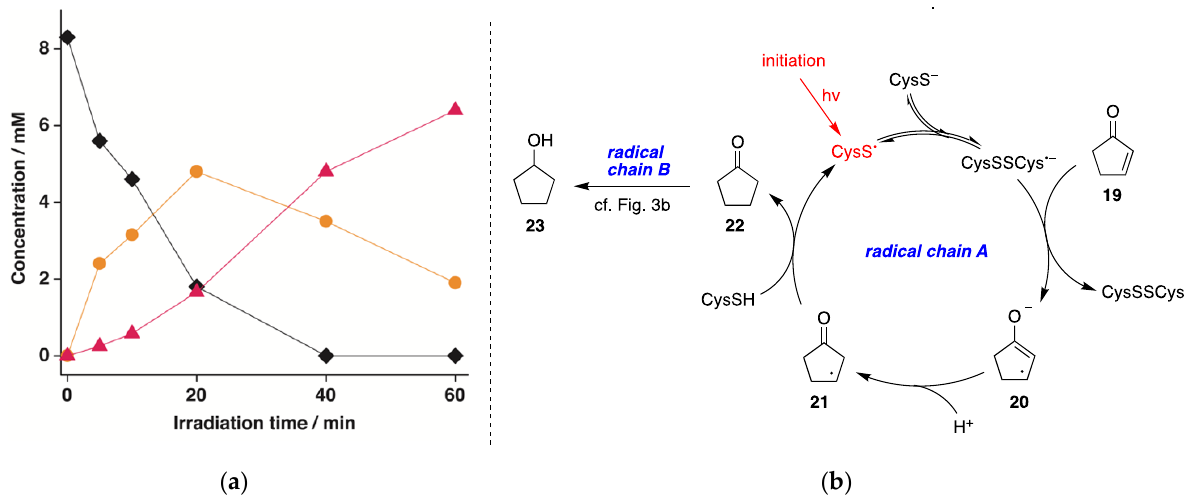
Figure 6. ( a ) Concentration of 19 ( (cid:7) ), 22 ( • ), and 23 ( (cid:78) ) vs. irradiation time for the photolysis of N 2 -saturated 2-cyclopenten- 1-one ( 19 ) aqueous solutions (8.3 mM) containing CysSH (18.3 mM), pH adjusted to 10.6, at 42 ± 1 ◦ C; ( b ) Proposed reaction mechanism involsving dual radical chain reactions A and B.